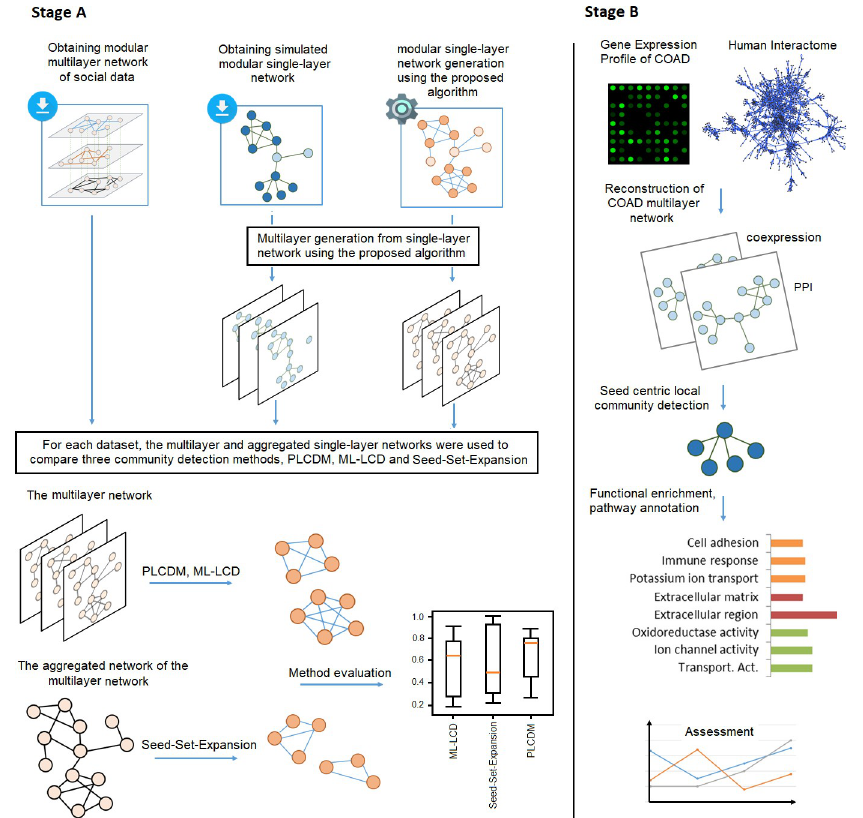
Fig 1. The roadmap of the study. Stage A) , Method evaluation. Here, to verify the performance of the proposed algorithm, three datasets were used: 1- a multilayer network constructed from a generated artificial modular single- network (created through a modular single-network generation algorithm, see S1 Appendix), 2- a multilayer network simulated from a synthetic modular single-network provided by the Graph Challenge data repository, and 3- a real social multilayer network published by Rossi et al. [57], based on five social interconnections (Facebook, lunch, coauthor, leisure, and work). The multilayer simulation algorithm in cases 1 and 2 was described in S1 Appendix. In all these three multilayer datasets, gold-standard communities were specified previously. For every dataset, the original multilayer and the aggregated single-layer network is used by methods PLCDM and ML-LCD (multilayer-specific), and Seed-Set-Expansion (single-layer-specific) to explore communities. Stage B), Application of the PLCDM on a reconstructed two-layer network of the colon adenocarcinoma (COAD). one of the constraints mentioned above. It is worth mentioning that Γ ( i ) denotes the neighbor l set of node i in layer l (Eq 3), and ω ( i , j ) is the weight of edge ( i , j ) (defined in Eq 4) in the multi-